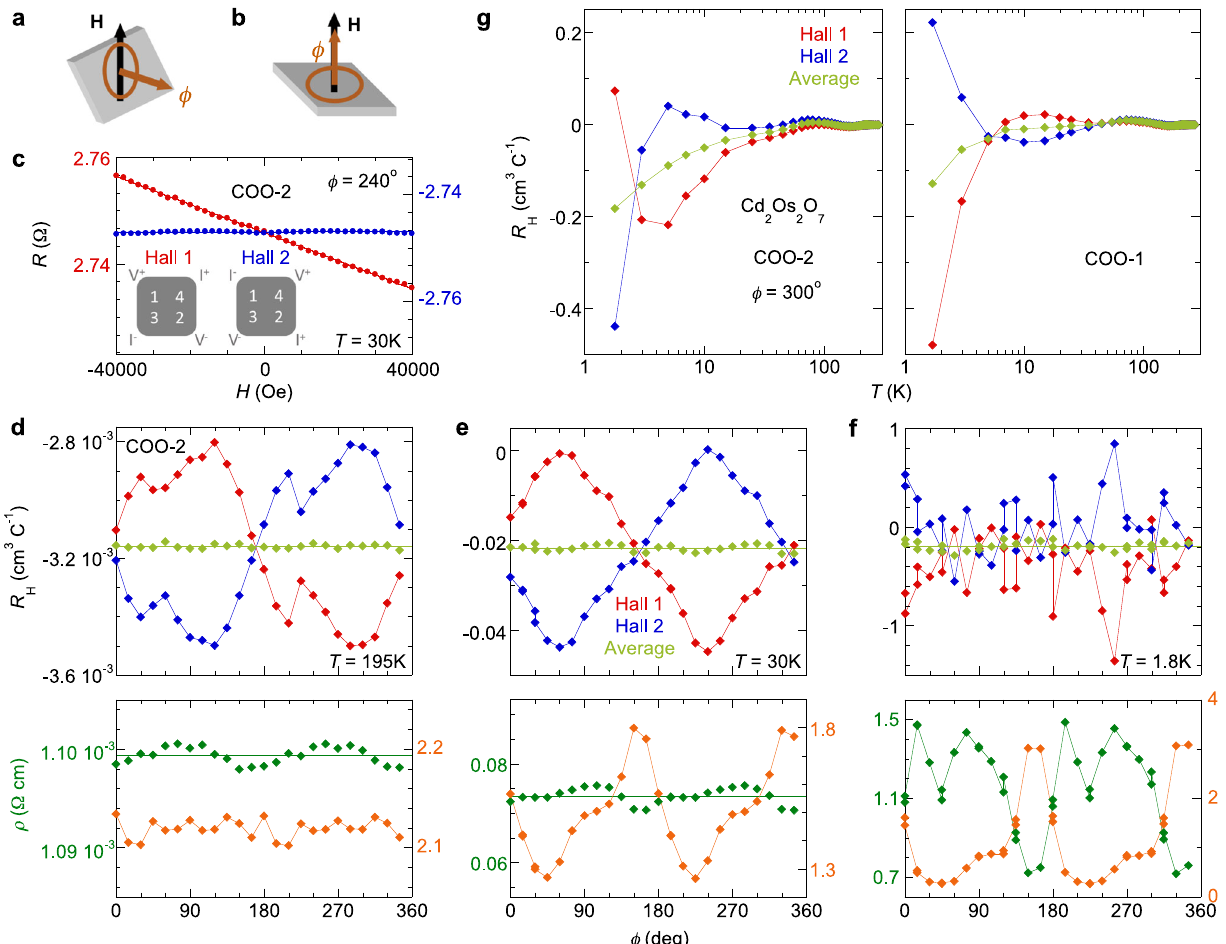
Fig. 2 Separating the in fl uence of metallic ferromagnetic domain walls. a , b Schematics of the measurement procedure using the two-rotator setup. Every galvanomagnetic Cd 2 Os 2 O 7 sample (gray plate) is fi eld-cooled in two stages: a fi eld H is aligned parallel to the sample surface at room temperature before cooling down through T N , and b the sample is rotated below T N to have a fi eld perpendicular to its surface for galvanomagnetic measurements. The in-plane magnetizing direction is de fi ned by angle ϕ at 24 discrete positions, set outside the cryostat at room temperature. c Typical raw data of Hall resistances R ( H ) between two reciprocal channels, measured for sample COO-2 at a speci fi ed temperature and magnetization angle ϕ . The difference in slopes indicates the in fl uence of asymmetric linear magnetoresistance from ferromagnetic domain walls 21 . (inset) vdP con fi guration for the two reciprocal Hall channels. d – f ϕ -dependence of Hall resistivity slopes R H in two reciprocal channels (red and blue) and their average (fresh green), in addition to the resistivity ρ (green) and vdP ratio (orange), measured in sample COO-2 at three temperatures 195, 30, and 1.8 K. (Methods) ( g ) Hall resistivity slopes R H from two reciprocal channels (red and blue) are plotted alongside their average (fresh green) for two different single-crystal Cd 2 Os 2 O 7 samples COO-1 and COO-2. Although the resistance slopes of an individual Hall channel are very different for each sample, with occasional crossings at various temperatures, the averages are similar in shape between the two samples and determine the bulk Hall coef fi cient R H ( T ). This irregular behavior of resistance slopes of individual Hall channels highlights potential experimental de fi ciencies in previous Hall measurements. All statistical uncertainties are smaller than the